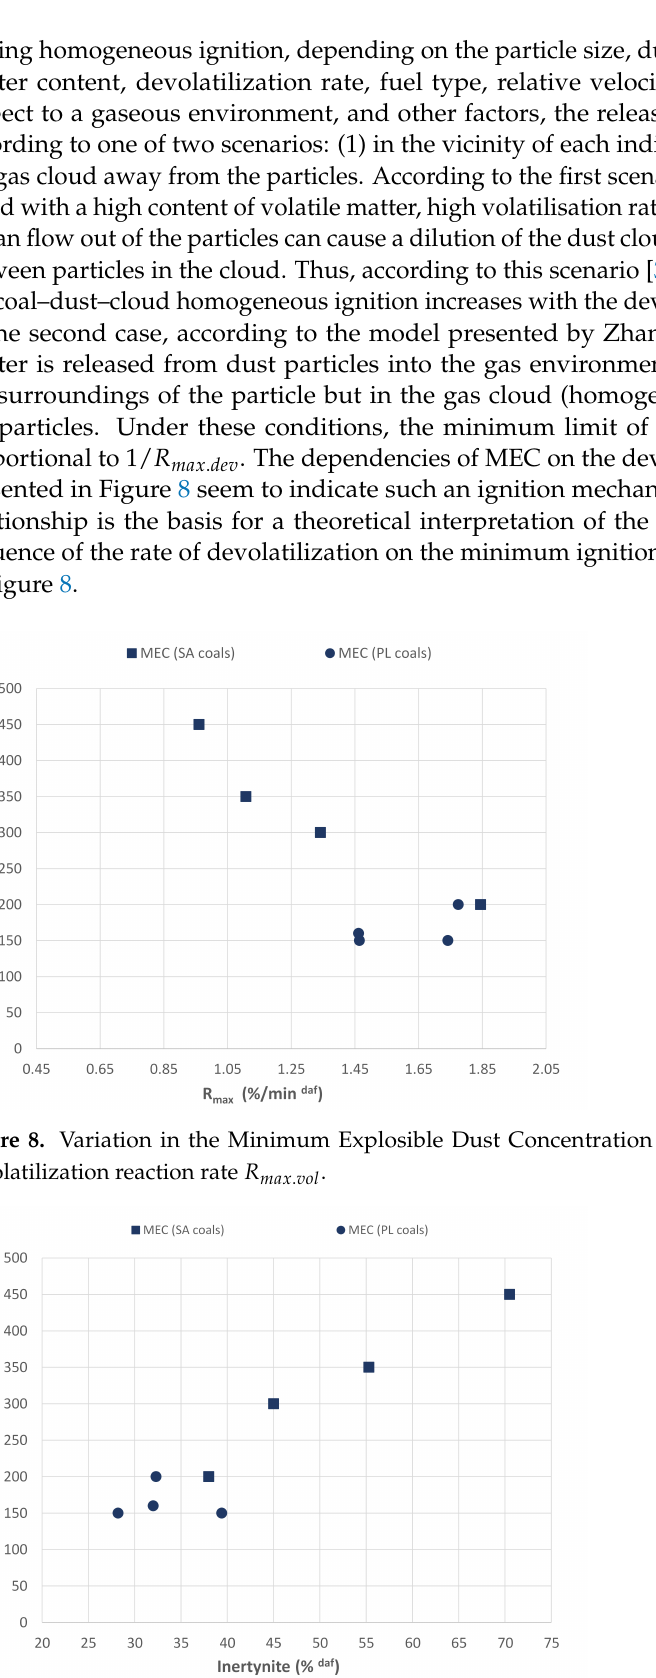
Figure 9. Variation in the Minimum Explosible Dust Concentration (MEC) with inertinite content of